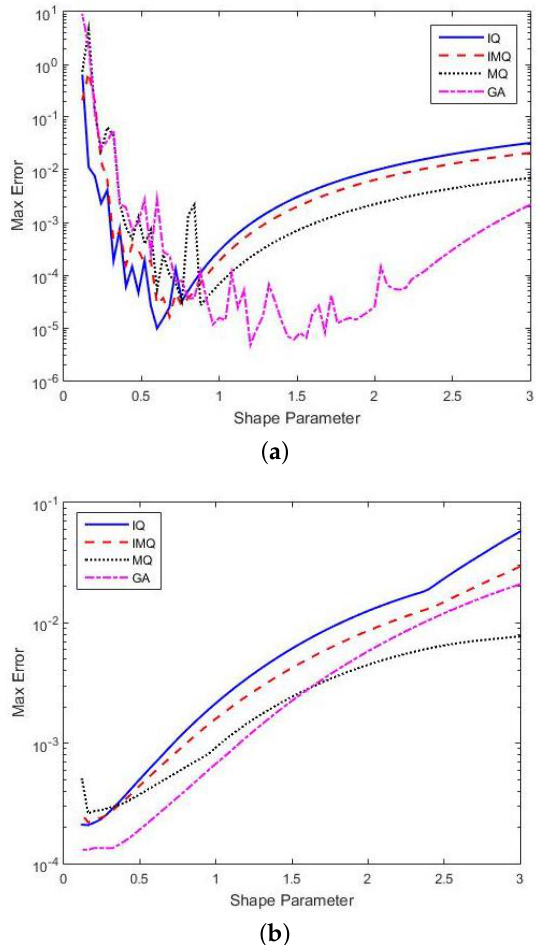
Figure 2. The graphs of max error are presented as a function of shape parameter. They compare max error of the results of global radial basis function (RBF) and radial basis function-finite difference (RBF-FD) methods. ( a ) global RBF scheme; ( b ) local RBF